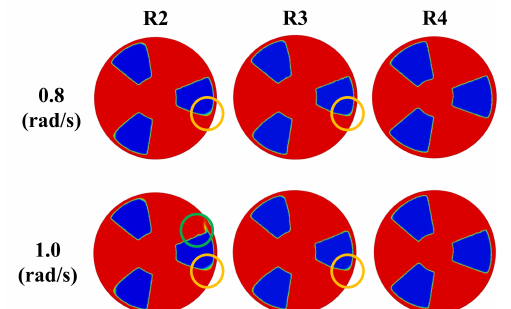
Figure 10. Contours of the mole fraction of nitrogen on the plate rotating clockwise in R2 , R3 and R4 with a gap distance of 5 mm in the angular velocities of 0.8 and 1.0 rad/s. The legend for the contours is present in Figure 9. A ring in orange denotes a nitrogen invasion into the BDEAS reaction zone, and a ring in green denotes the BDEAS runoff from the reaction